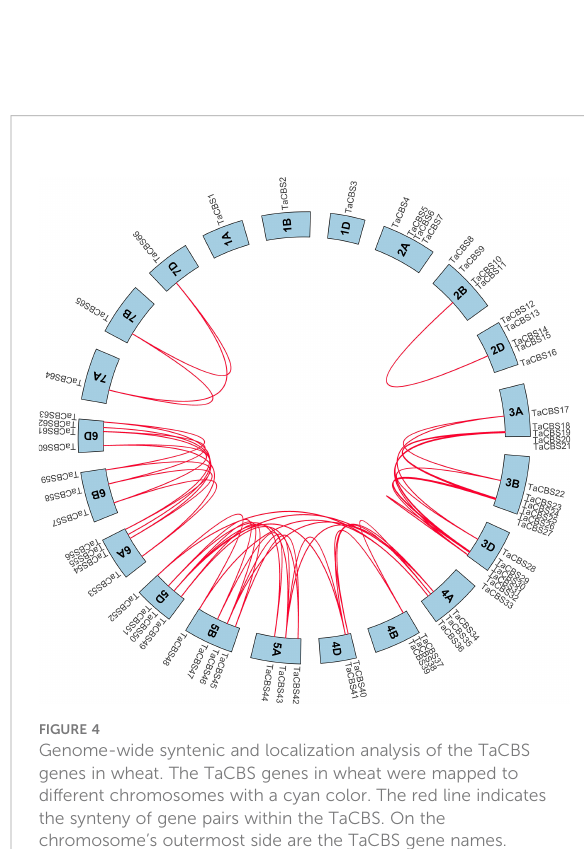
FIGURE 4 Genome-wide syntenic and localization analysis of the TaCBS genes in wheat. The TaCBS genes in wheat were mapped to different chromosomes with a cyan color. The red line indicates the synteny of gene pairs within the TaCBS. On the chromosome ’ s outermost side are the TaCBS gene